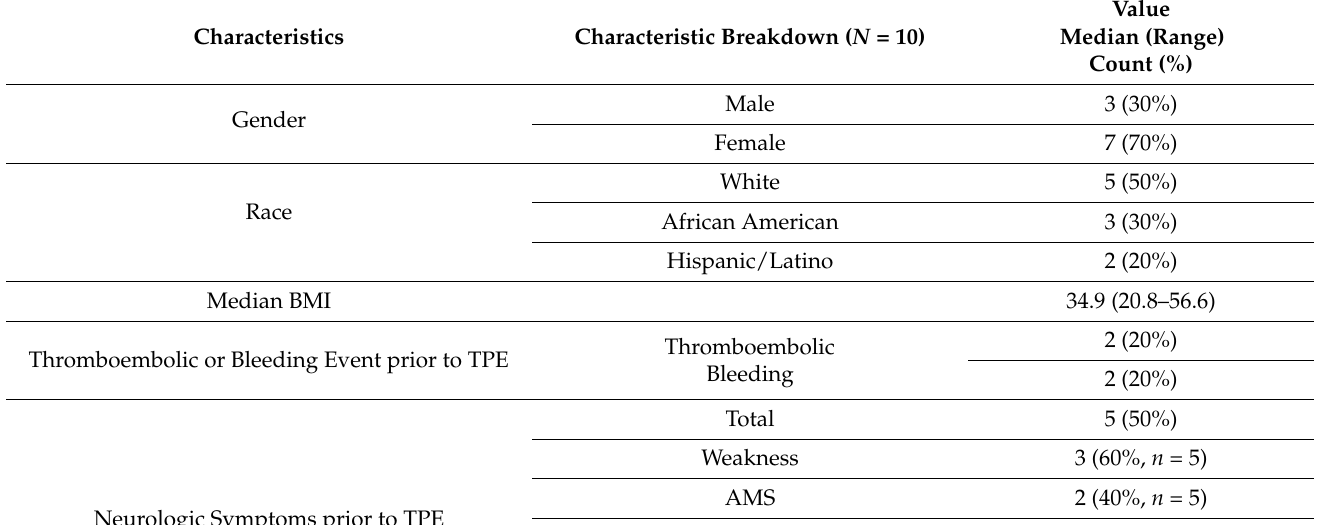
Table 1. Patient Cohort